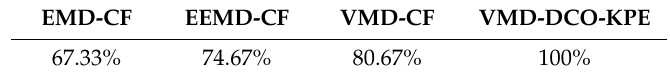
Figure 13. The frequency distributions of VMD-DCO-KPE and VMD-CF. Table 10. The classification results of different frequency feature extraction methods.